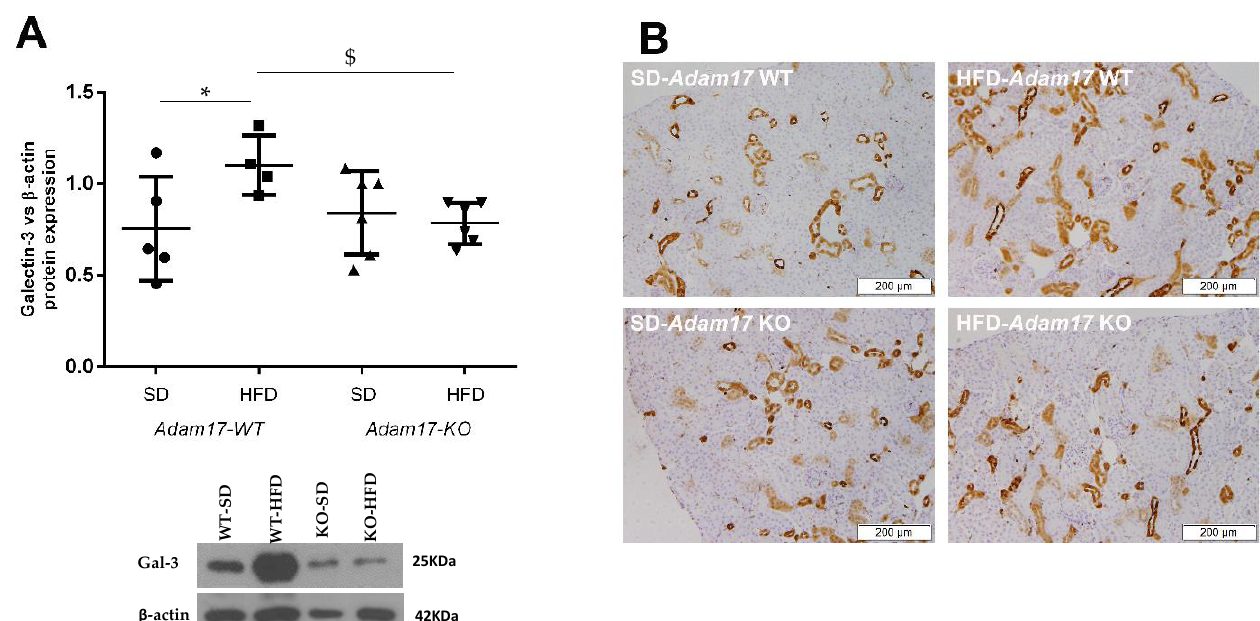
Figure 4. Influences of HFD and endothelial Adam17 deletion on galectin-3 expression. ( A ) Galectin-3 expression measured by Western blot ( n = 4–6). ( B ) Representative images of galectin-3 immunostaining. 100× magnification, scale bar 200 μ m. Data are expressed as mean ± SD. Abbreviations: